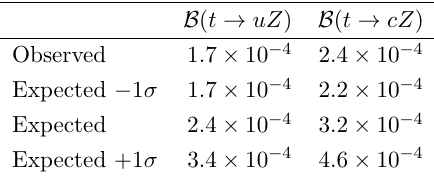
Table 10 . Observed and expected 95% CL upper limits on the FCNC top-quark decay branching ratios. The expected central value is shown together with the (cid:6) 1 (cid:27) bands, which includes the contribution from the statistical and systematic uncertainties.